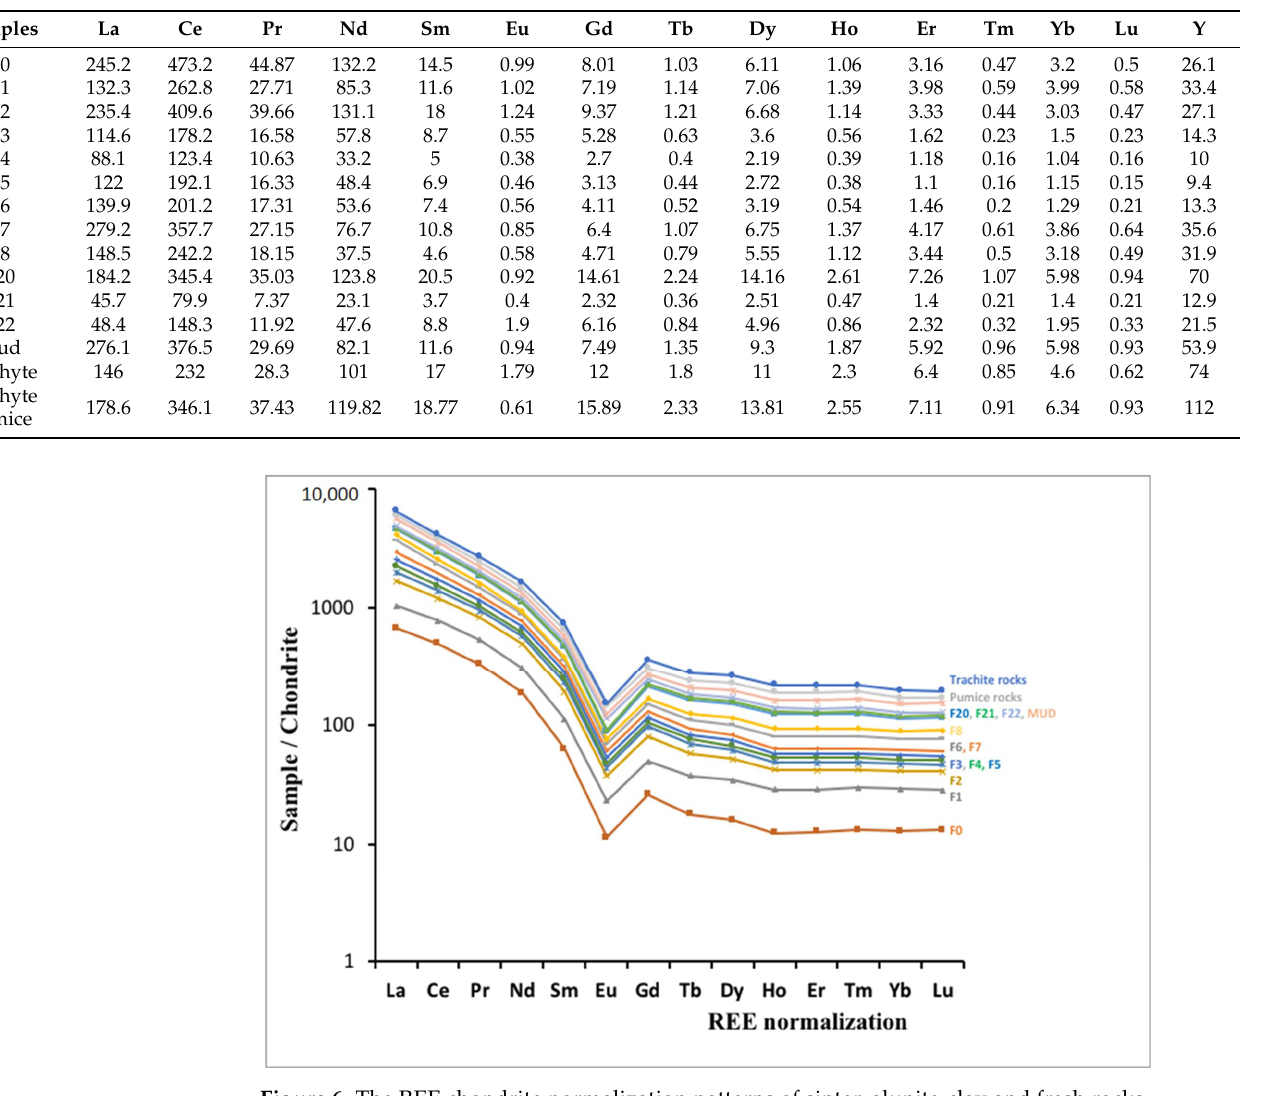
Figure 6. The REE chondrite normalization patterns of sinter, alunite-clay and fresh rocks. The ∑ REE (Table 5) ranges from 169.05 to 934.5 ppm in acid-sulfate rocks, values higher than those found in trachyte rocks (565.66 and 751.2 ppm). Higher ∑ REE concentra- tions (from 431.49 to 934.5 ppm) contain kaolin − alunite and smectite + kaolin + alunite assemblages. The REE uptake into the sinter rocks (169.05 to 268.93 ppm) is of 2 to 4 orders magnitude lower than in alunite + kaolin assemblage. In addition, a high LREE (156.07 to 895.47 ppm) fractionation compared with HREE (2.54 to 15.25 ppm) characterizes the selected samples. The (LREE/HREE) N ranges from 4.22 to 18.36 in acid-sulfate rocks comparatively with fresh rocks (12.47 and 12.39). The Eu/Eu* anomaly (Table 5) is